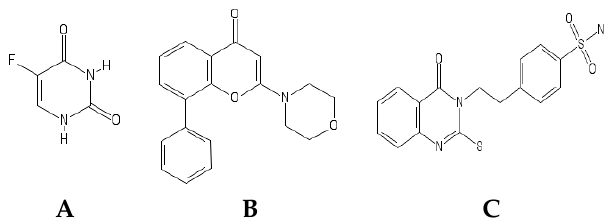
Figure 1. Molecular structures of ( A ) 5FU, ( B ) LY294002, and ( C ) HAA 2020.